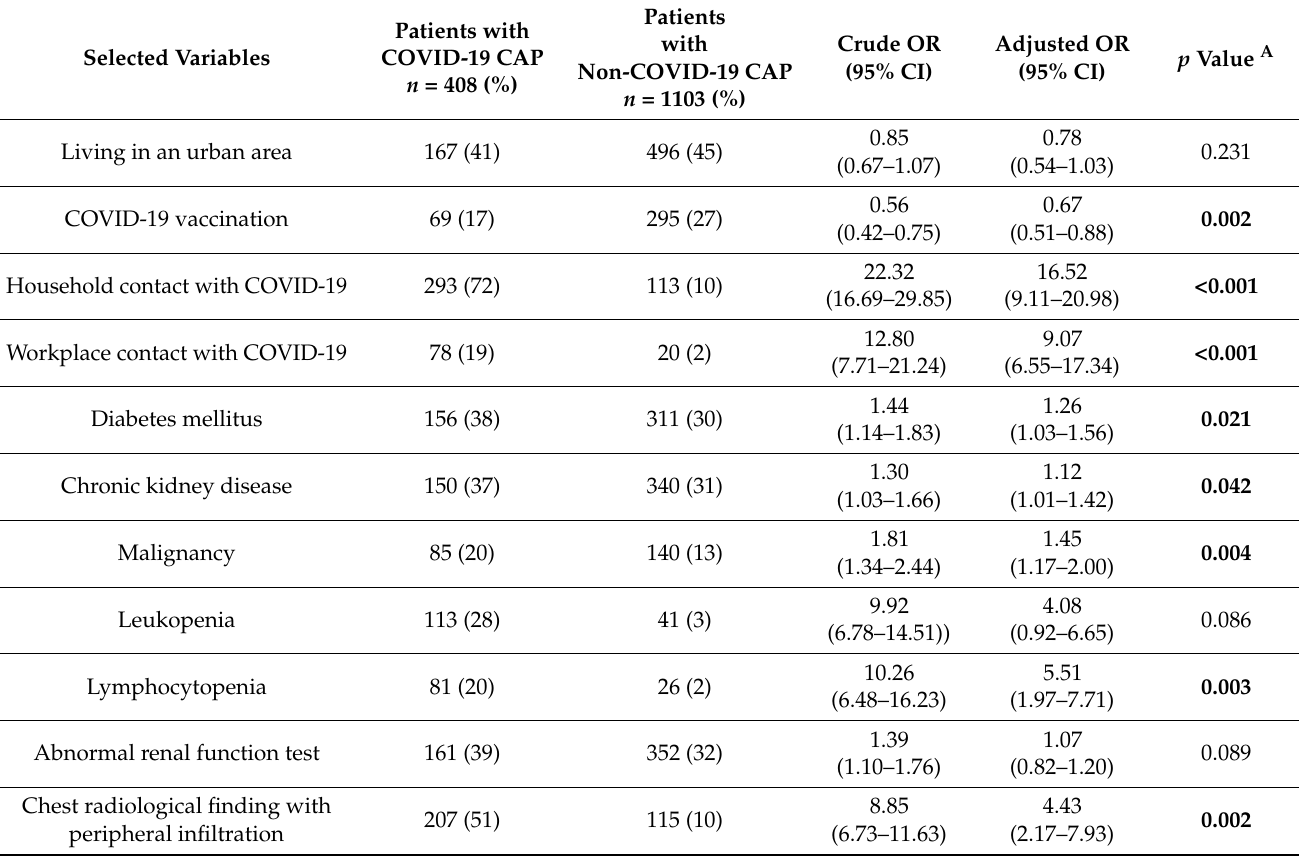
Table 3. Characteristics associated with community-acquired pneumonia (CAP) due to coronavirus disease 2019